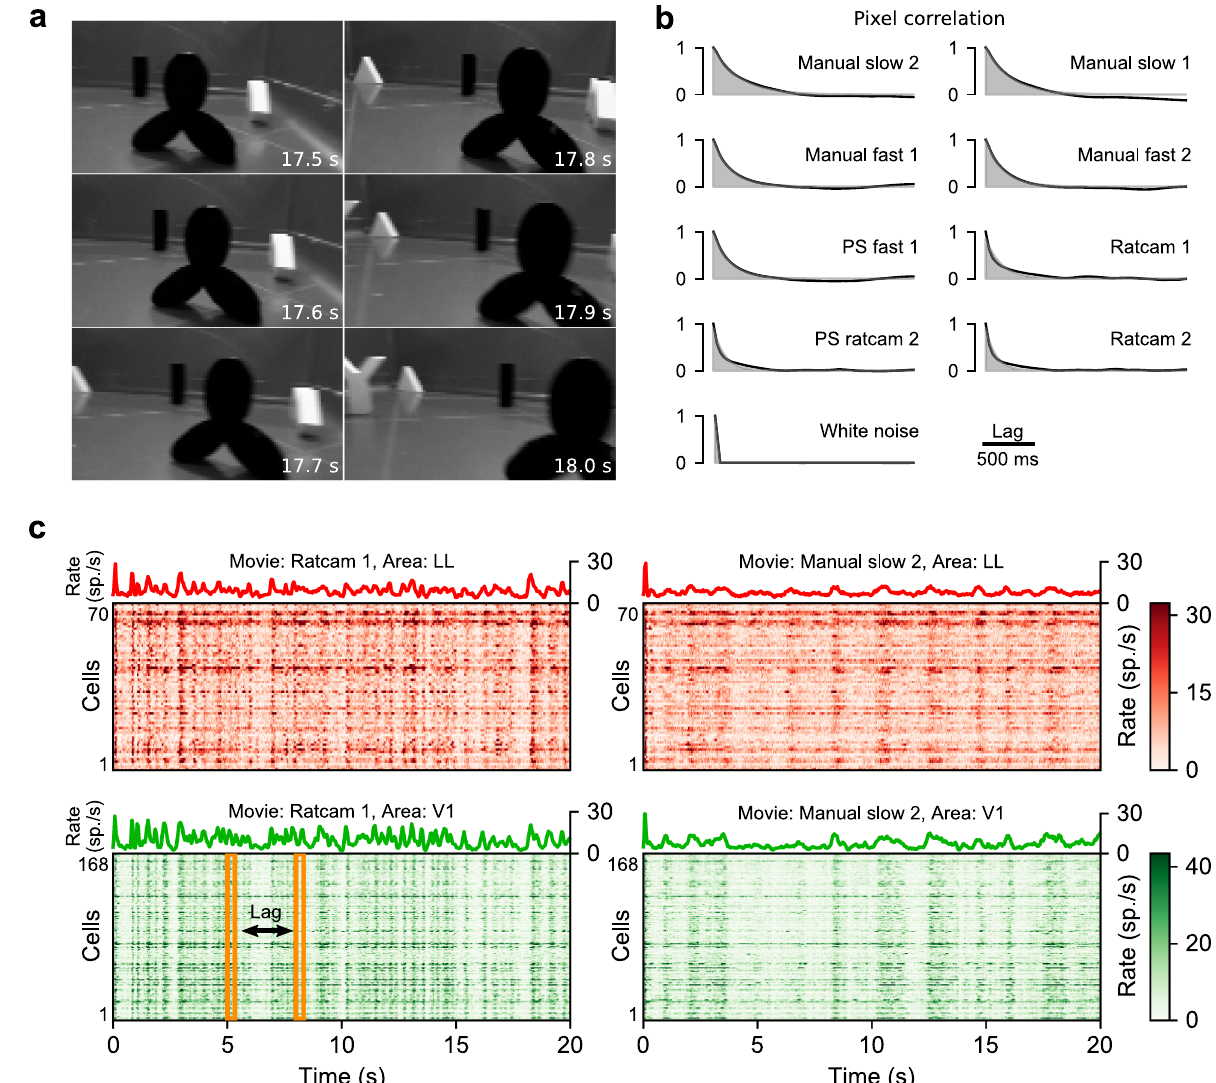
Fig. 3 Visual stimuli and example neuronal recordings. a Six consecutive example frames from one of the movies used as visual stimuli in our study. The numbers on the bottom right of each panel give the time at which each frame appears. b Quanti fi cation of the characteristic timescale of the individual visual stimuli (movies). The Manual and Ratcam labels refer, respectively, to movies that were taken either by moving a hand-held camera across an arena fi lled with 3D-printed objects (some of them visible in a ), or by installing a small camera over the head of a rat that was allowed to roam inside an arena containing the 3D-printed objects and another rat. The PS label refers to Fourier phase-scrambled versions of the corresponding movies (see “ Methods ” for details). In each panel, the black line shows the average correlation of pairs of image frames within a movie as a function of their temporal lag, while the shaded area shows the best exponential fi t. c Examples of population responses to two of the movie stimuli. In the color matrices, each row color-codes the intensity of the trial-averaged response (computed in 33-ms time bins) of a neuron belonging to either the LL (red) or V1 (green) population. The color- code is truncated to the 98th percentile of the fi ring rate distribution within each area for ease of display. The trace on top of each matrix shows the corresponding population-averaged response. The yellow frames illustrate the procedure to compute the characteristic timescale over which the population activity unfolded, in response to a given movie (see Fig. 4a, b). Source data are provided as Source Data fi